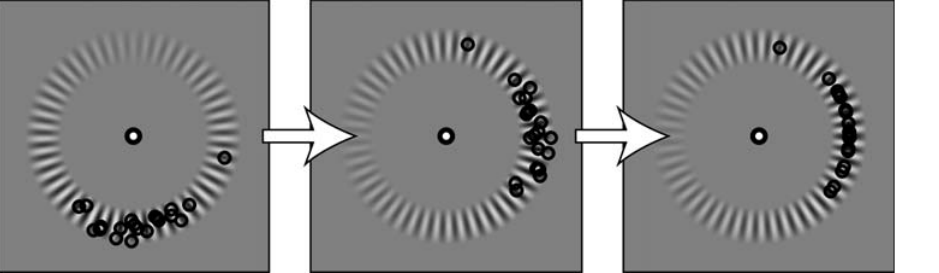
Figure 3. Transformation of the data. Data for each condition were rotated to represent the data as corresponding to the highest value of the stimulus parameter at the 0 deg position. Next, data were put on a unit circle and convoluted with a Gauss (see Result for details).